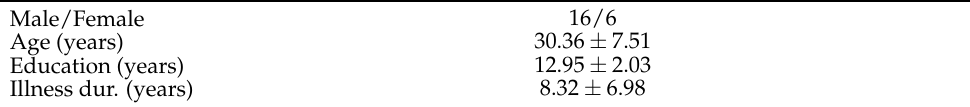
Table 19. Demographics